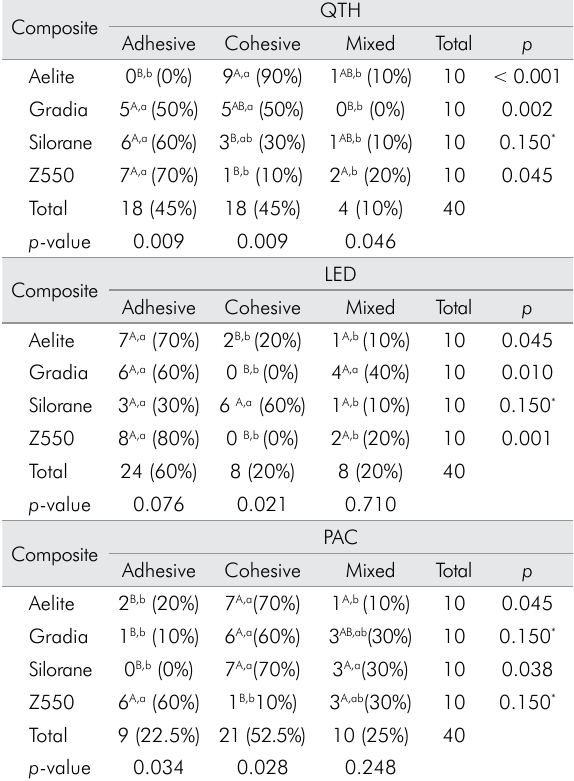
Table 4. Distribution of Failure